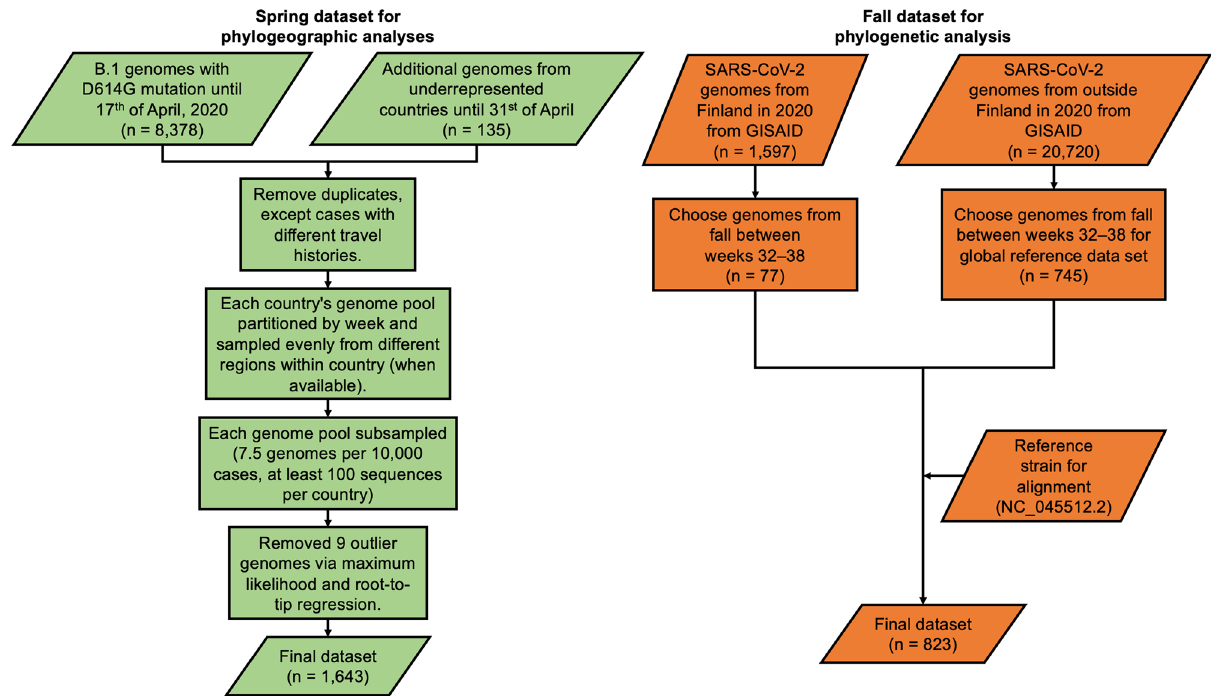
Fig. 2 Flowchart of sequence data acquisition and sampling and/or selection for spring and fall analyses. Available Finnish SARS-CoV-2 sequences (Supplementary Data 2) were divided into spring and fall datasets based on the peaks in COVID-19 cases during